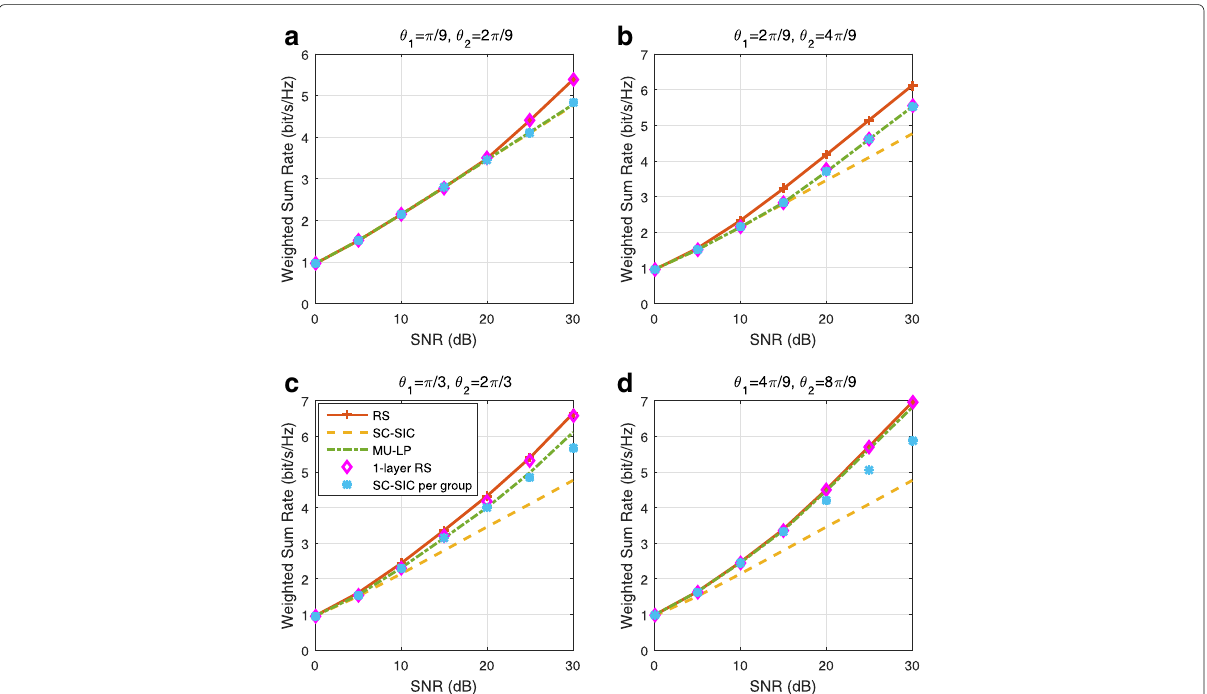
Fig.50 WeightedsumrateversusSNRcomparisonofdifferentstrategiesforunderloadedthree-userdeploymentwithimperfectCSIT, γ 1 = 1, γ 2 = 0.3,